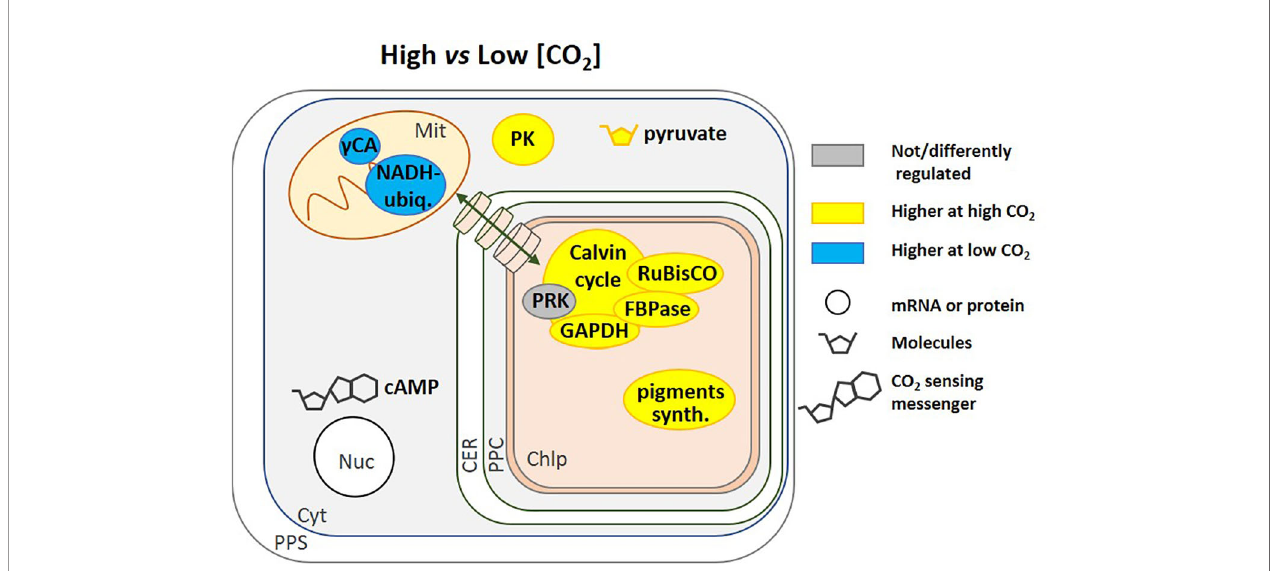
FIGURE 4 | Regulation of pathways by [CO 2 ]. This schematic includes regulatory pathways from different species, including N. oceanica (Wei et al., 2019) and T. pseudonana (Clement et al., 2017b; Jensen et al., 2019b). Cyclic AMP (cAMP) is a general [CO 2 ] signalling molecule that regulates gene expression (Ohno et al., 2012; Hennon et al., 2015; Young and Morel, 2015). High CO 2 corresponds to 20,000 to 50,000 ppm but in Hennon et al. (2015) it is 800 ppm and low CO 2 is 50 to 400 ppm. The transport of molecules between the cytoplasm and the chloroplast is represented by a green double-headed arrow across cylinders. NADH ubiq., NADH-ubiquinone oxidoreductase complex; PK, Pyruvate Kinase; pigments synth., pigments synthesis; CA, Carbonic Anhydrase; PPS, Periplasmic Space; CER, Chloroplast Endoplasmic Reticulum; PPC, Periplastidial Compartment; Mit, Mitochondrion; Chlp, Chloroplast; Cyt, Cytoplasm; Nuc,